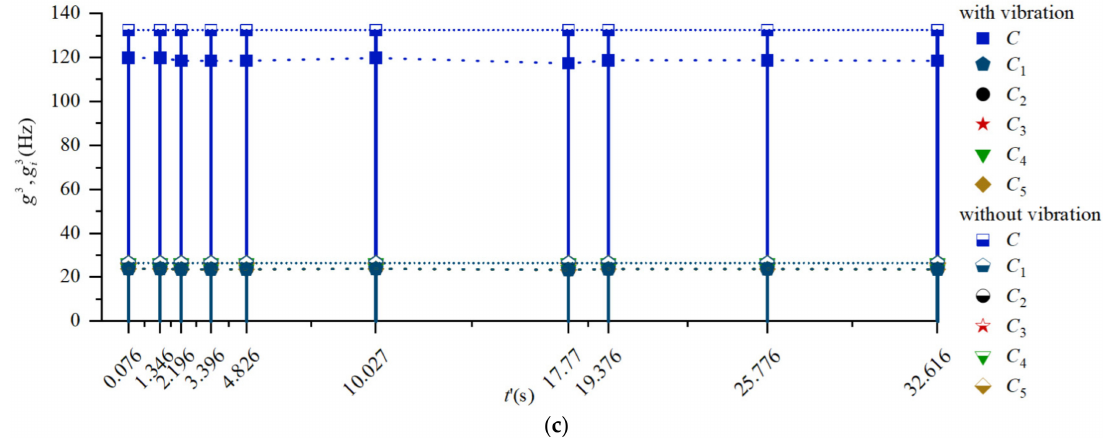
Figure 9. Time–frequency parameters of main cutting force energy consumption with/without milling vibration and cutter tooth errors, ( a ) root mean square, ( b ) kurtosis, ( c ) dominant